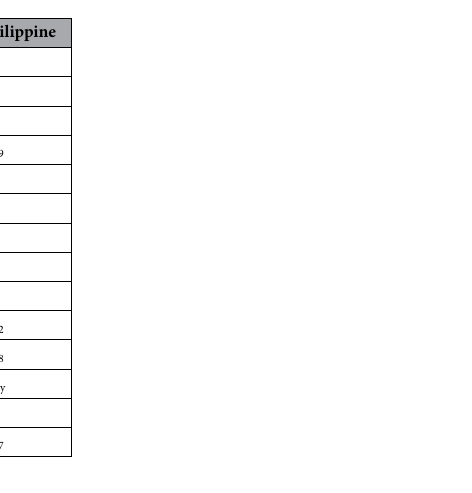
Table 2. Risk index